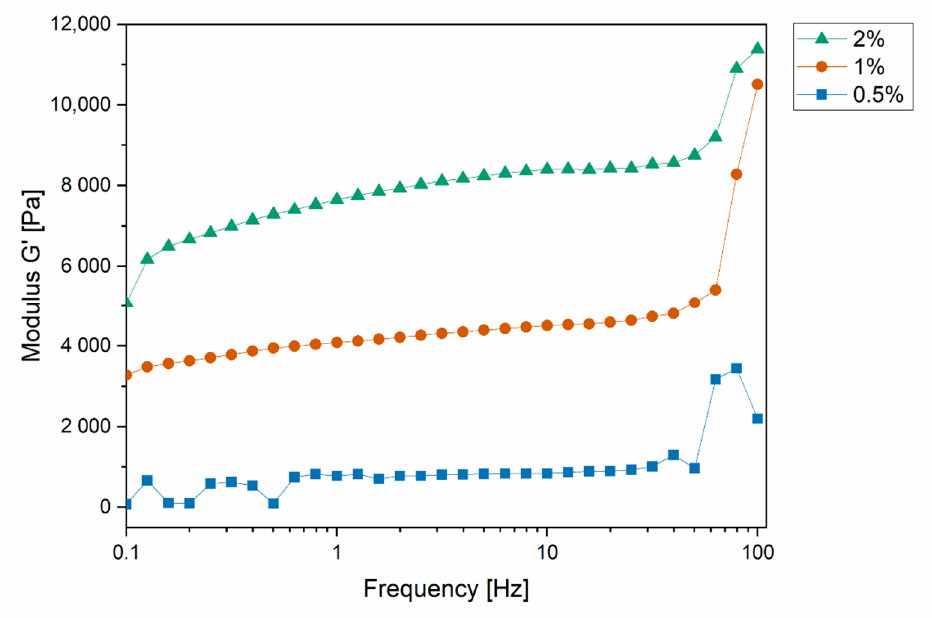
Figure 6. Storage modulus received from frequency sweep measurement with a set shear strain of 0.3% for determination of the storage modulus at the plateau phase. Table 2. Storage (G’) and loss moduli (G’’) received from frequency sweep measurement and calcu- lated from these measurements, the mesh size (ξ) and crosslink density (N ε ).